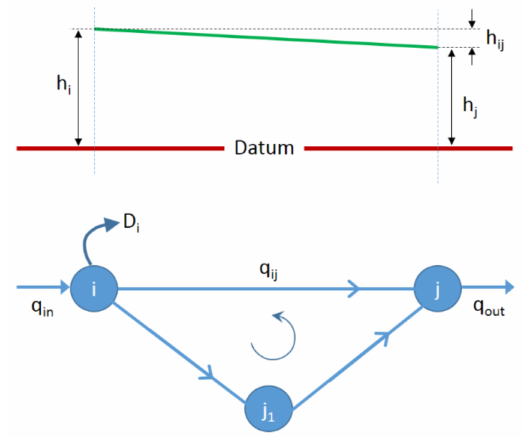
Figure 2. Node-link representation in